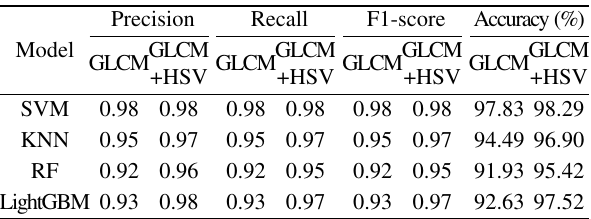
Table 6 Performance comparison of all